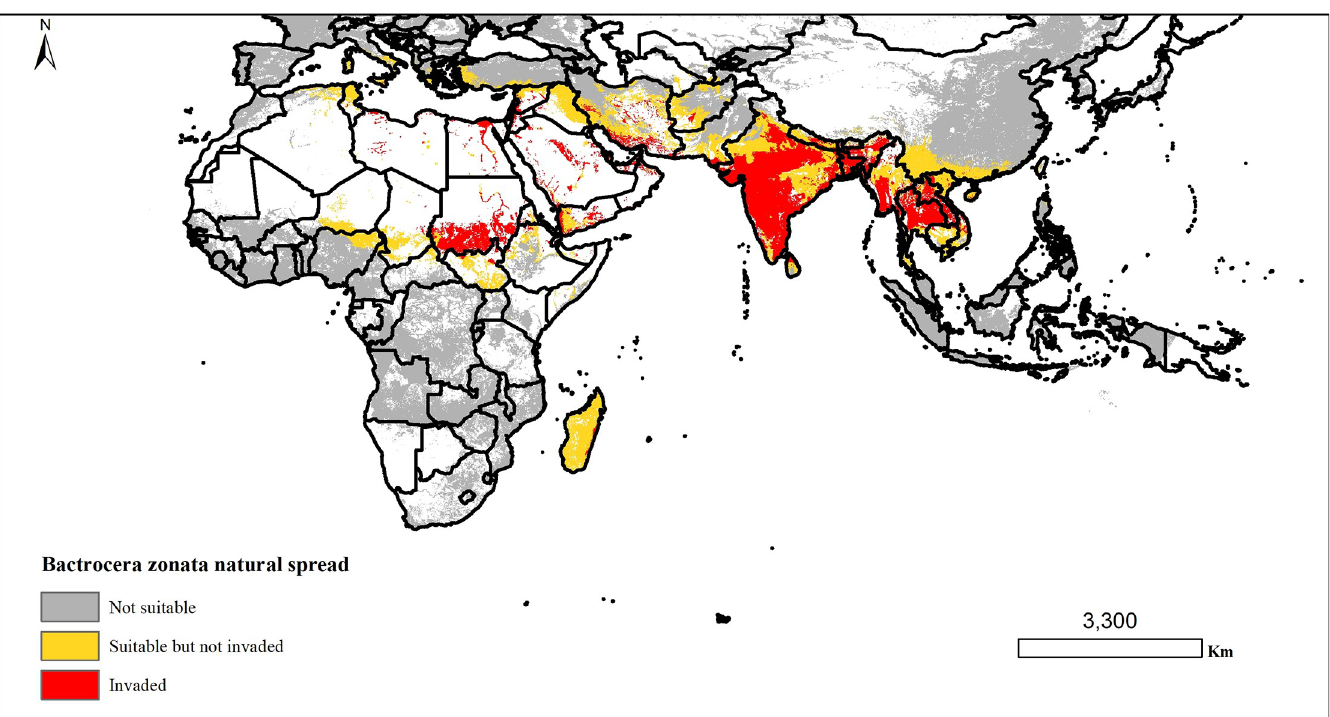
Fig 7. Predictions of the potential natural dispersal of Bactrocera zonata based on the simple spread model developed. The model was run for current climatic conditions for one generation of Bactrocera zonata (about 46 days), it is known to have between 7 and 9 generations in a year [20]. “The figure was generated using the QGIS 3.10.2 software (https://qgis.org)”.